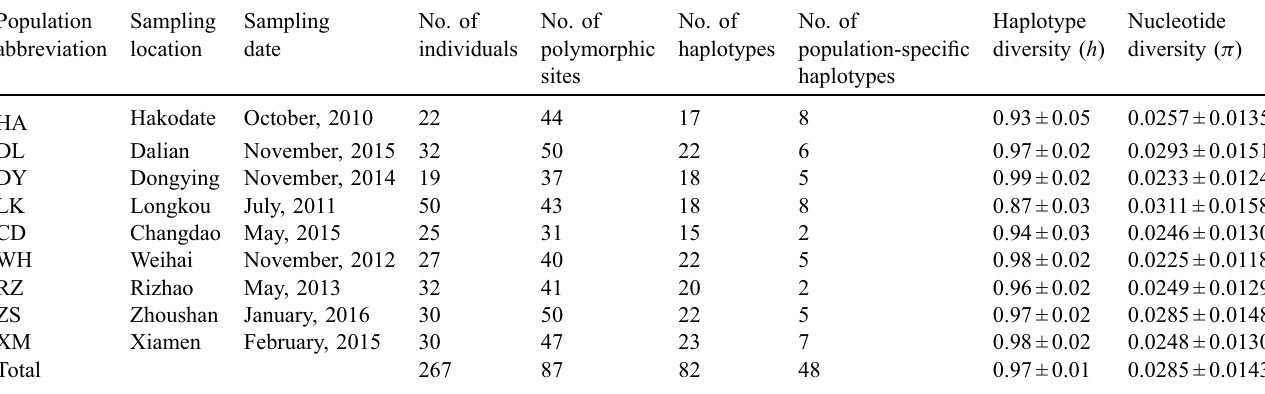
Table 1. Sample information and diversity index of T.